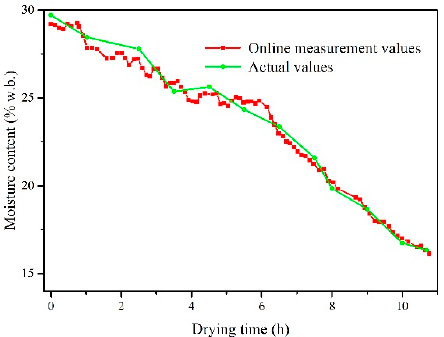
Figure 16. Relationship between measured values and actual values of moisture content in field tests.